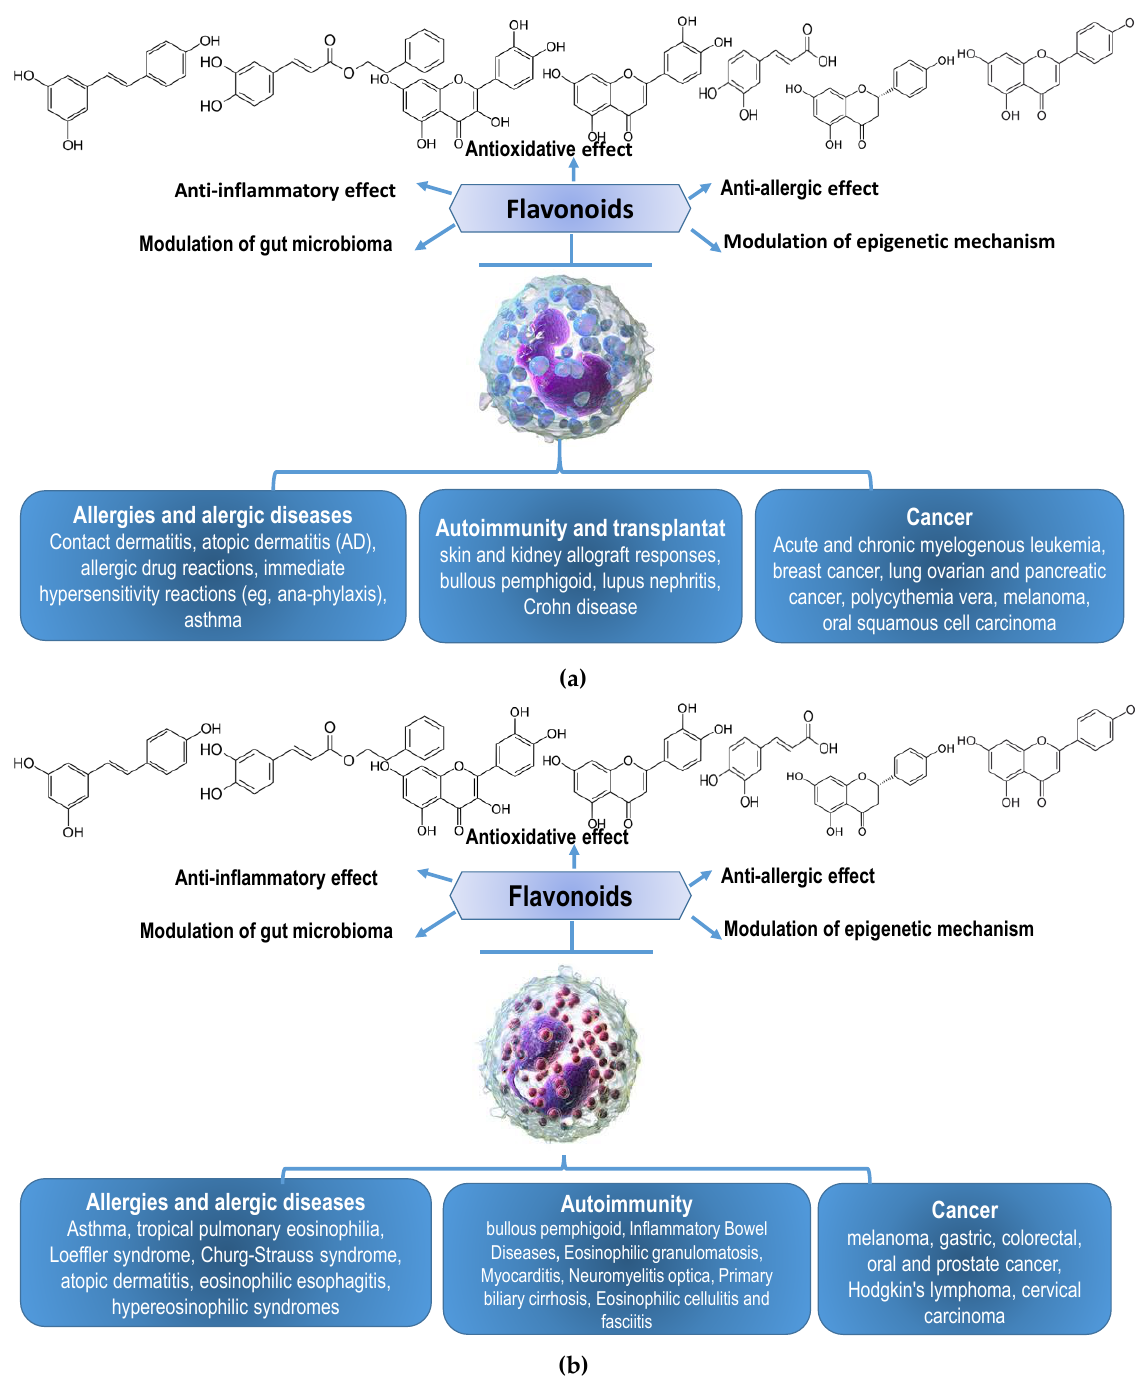
Figure 7. Propolis and flavonoids as candidates for preventing the development of inflammatory diseases, allergies, autoimmunity and cancer or as supplements to the management of basophils ( a ) and/or eosinophil-mediated diseases ( b ). Propolis and its flavonoid components can regulate basophils and/or eosinophil-mediated diseases by their antioxidant, anti-inflammatory, anti-allergic effects or through modulation of intestinal microbiota and epigenetic mechanisms. Propolis and its flavonoid components have confirmed their effects against allergic inflammations, allergic rhinitis, asthma, atopic dermatitis and food allergies and inflam- matory bowel and skin diseases in numerous in vitro studies on different cell models, and animal models. Their anti-inflammatory and anti-allergic effects are attributed to the in- hibitory effect of propolis on cells and their mediators involved in the inflammatory pro- cess, including activation of epithelial cells, mast cells, basophils and eosinophils and the release of various allergic mediators and cytokines. The most important active ingredients of propolis with anti-allergic properties are flavonoids, such as quercetin, chrysin, kaempferol, galangin and pinocembrin and cinnamic acid derivatives, such as CAPE and artepillin. Liew et al. [125] reported data on preclinical and clinical use of propolis as an adjunct in allergy therapy. As a supplement or an adjunct therapy, propolis is safe and attenuates various pathological conditions in asthma, atopic dermatitis, allergic rhinitis, and food allergies. The authors suggested that the anti-allergic activities of propolis may not be present in all propolis samples due to variations in chemical composition. Further- more, these data can promote further research regarding the possible protective effects of propolis and flavonoids in preventing allergic diseases and the isolation of propolis com- ponents that cause sensitization to propolis in a larger percentage of people. Considering certain epidemiological data and previous research, propolis and its active components may provide a form of complementary and alternative medicine in the prevention and treatment of allergic diseases. 7. Conclusions Propolis exerts anti-inflammatory/antiallergic activity, likely due to its antioxidant and anti-inflammatory properties. The protective role of propolis (via inhibition of the ROS formation pathway) occurs through retardation of NF- κB activation, inhibitio n of